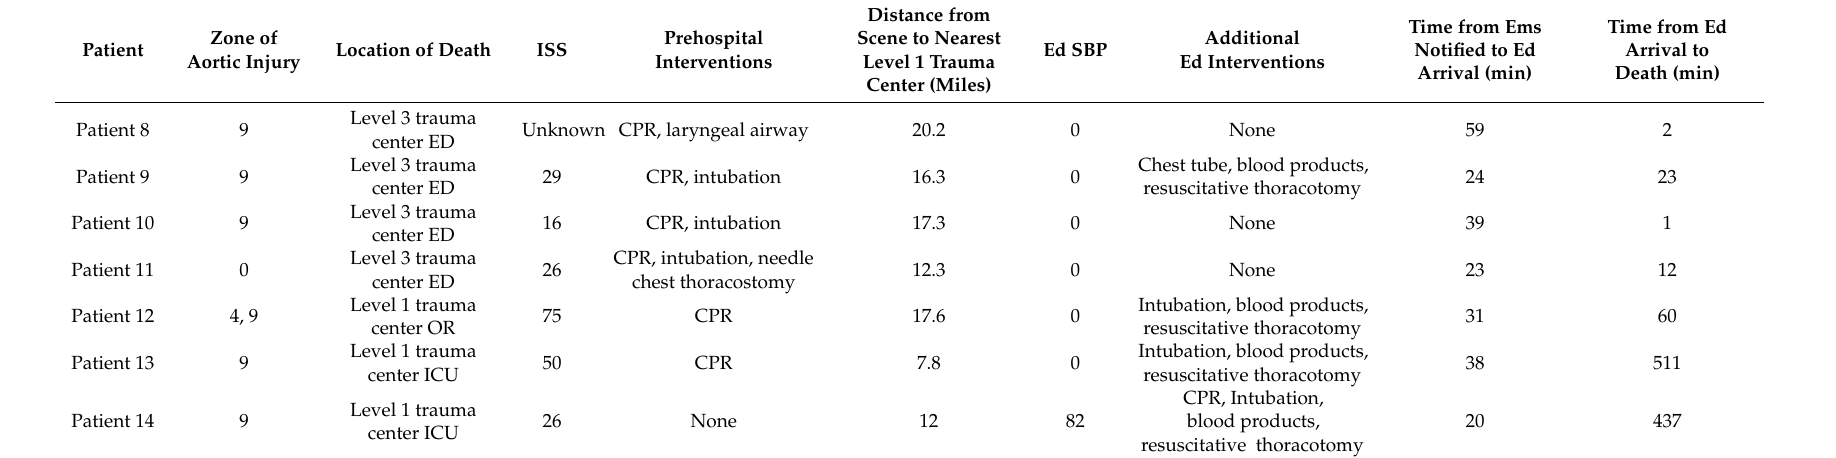
Table 5. Possibly preventable deaths who expired in-hospital. All patients su ff ered gunshot wounds and died of